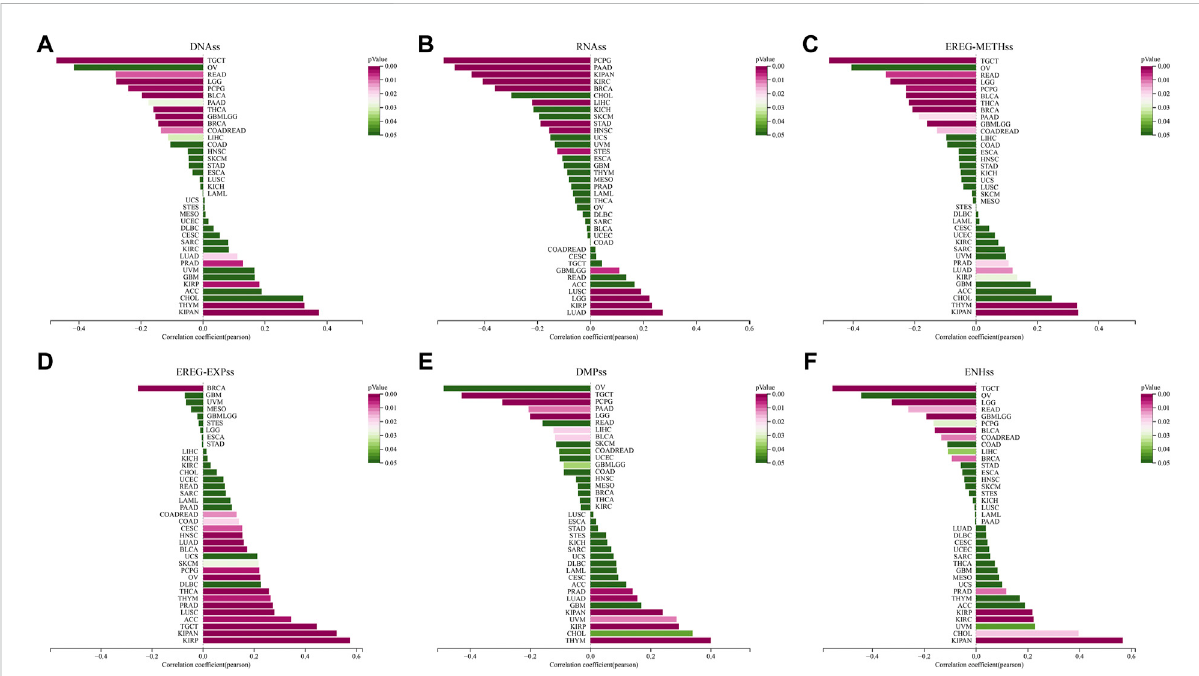
FIGURE 11 Correlation between STC2 expression and tumor stemness. (A – F) Relationship between STC2 expression and DNAss, RNAss, EREG-METHss, EREG-EXPss, DMPss and